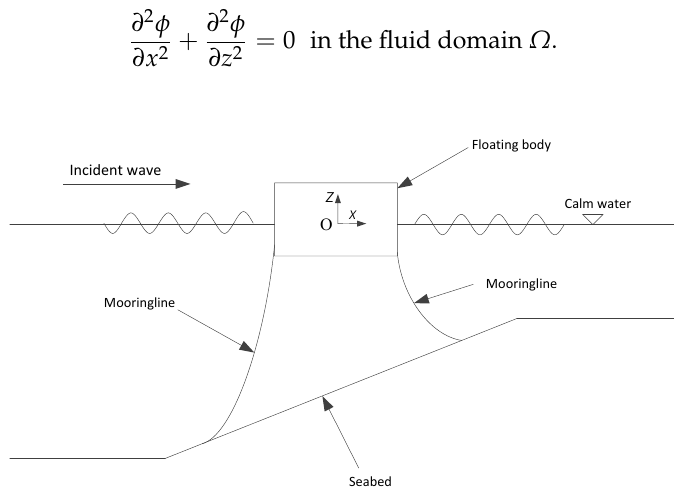
Figure 2. Illustration of a coupled floating body-mooring line model with a seabed